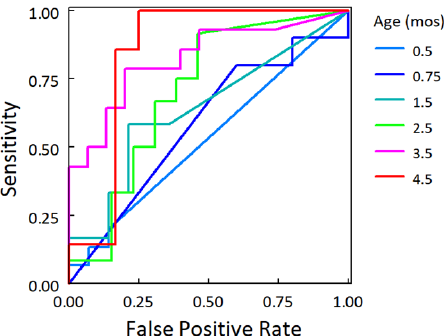
Figure 3. Receiver operating characteristic curves revealed discriminatory power of Ruminococcous gnavus to distinguish CMF group from EHF group by 3.5 – 4.5 months; logistic regression model.